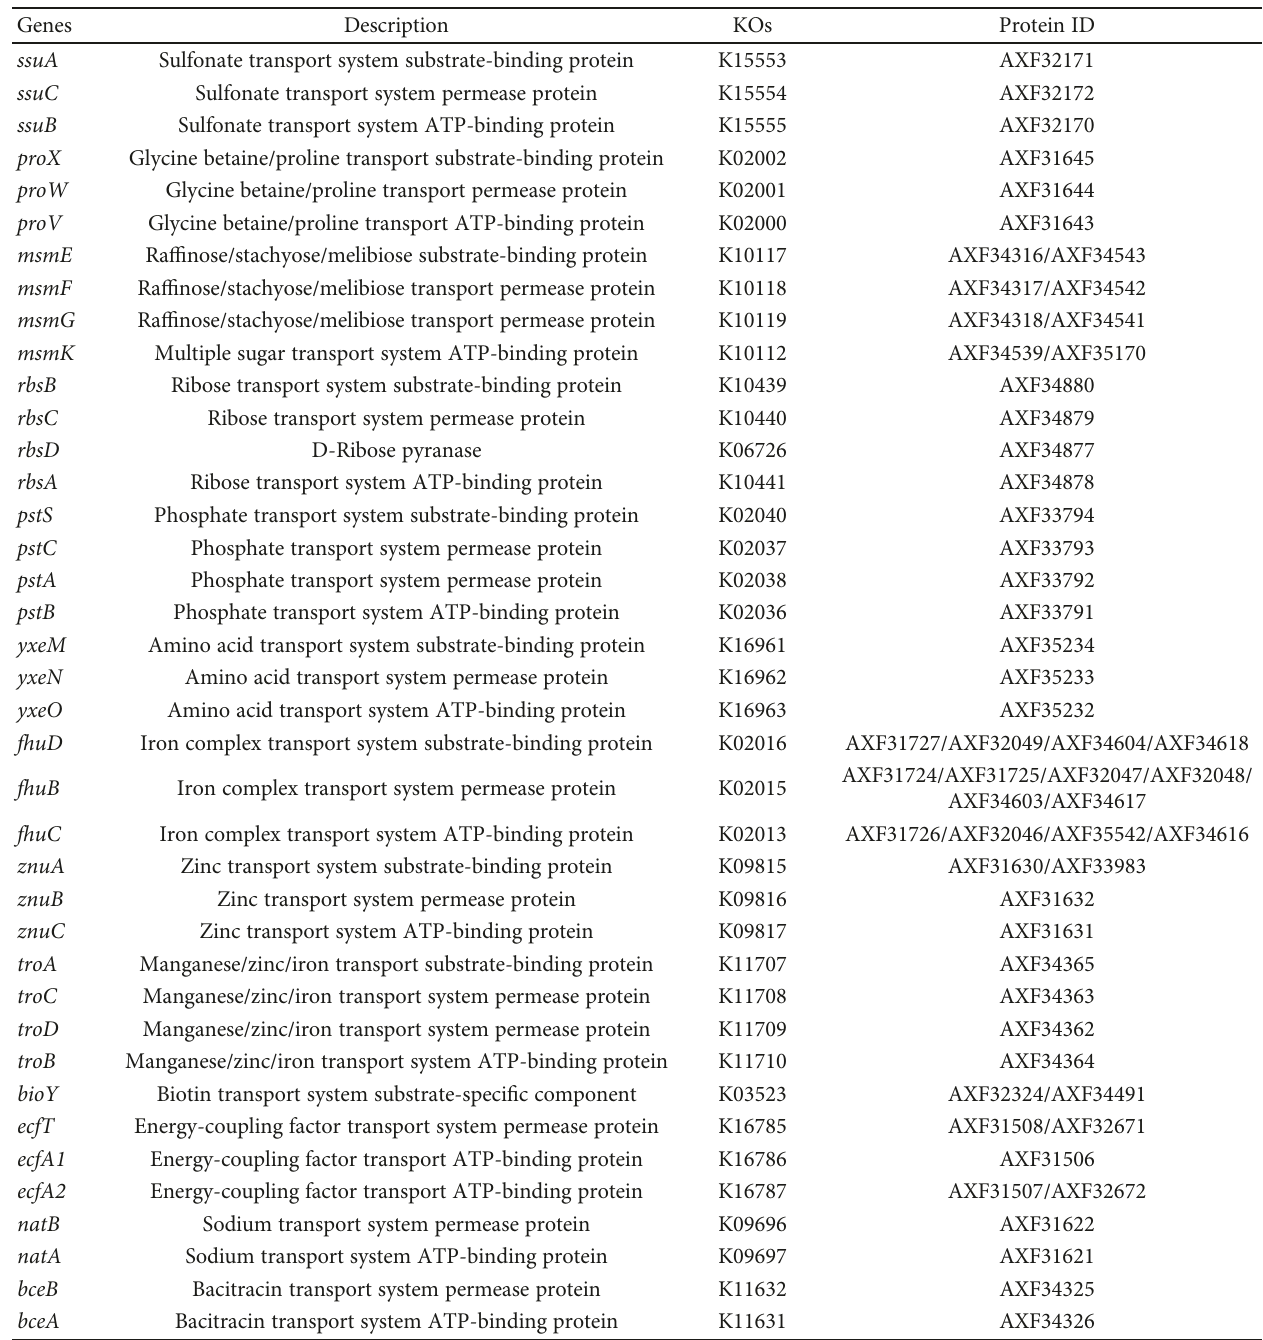
Table 8: The ABC transport systems in the genome of B. subtilis